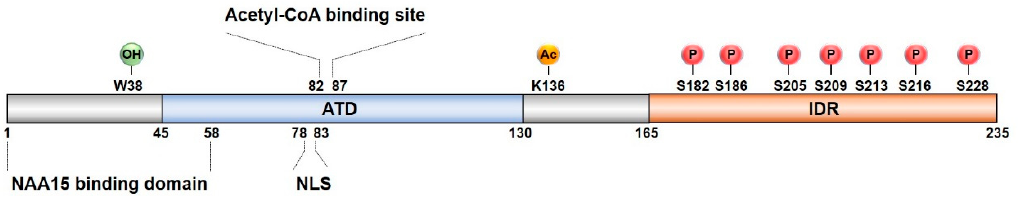
Figure 2. Domain structure of NAA10. The human NAA10 protein consists of 235 amino acids. Acetyltransferase domain (ATD) is located between amino acids 45 and 130, containing acetyl-CoA binding site and nuclear localization signal (NLS). N-terminal region of NAA10 is critical for the binding with NAA15 and C-terminal region is predicted as an intrinsically disordered region (IDR). NAA10 has several post-translational modification sites for phosphorylation, acetylation, and hydroxylation. Ac, acetylation; OH, hydroxylation; P, phosphorylation.